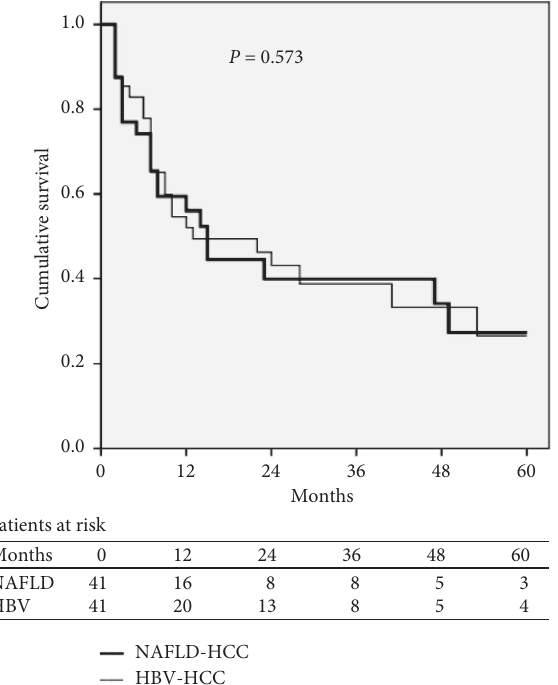
Figure 4: Survival curves of NAFLD-related and HBV-related HCC patients after propensity score matching analysis. HBV: hepatitis B virus; HCC: hepatocellular carcinoma; NAFLD: nonalcoholic fatty liver Table 5: Baseline characteristics of NAFLD-related and HBV-related HCC patients after a propensity score match analysis. Variables